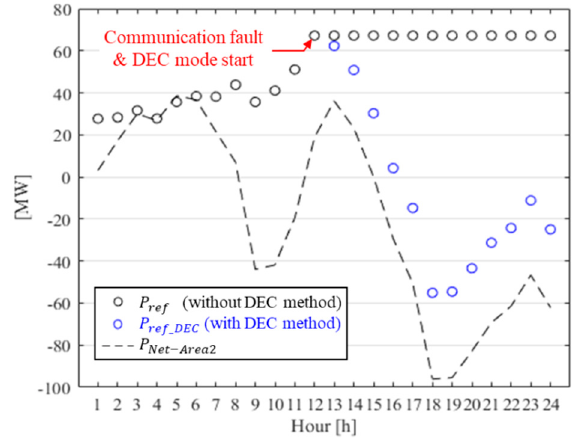
Figure 17. Comparison of operating points in two control mode.